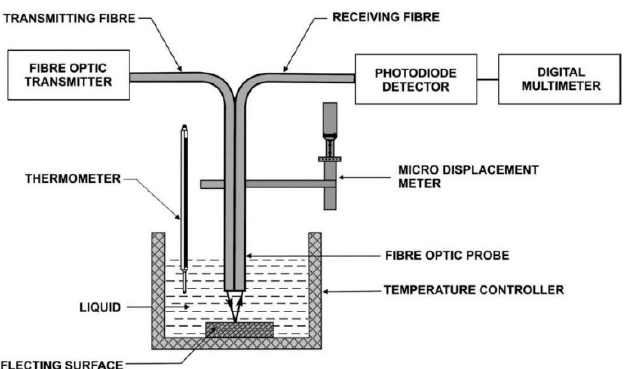
Figure 9. Schematic experimental setup to detect variation in the refractive index based on glucose concentration [81].